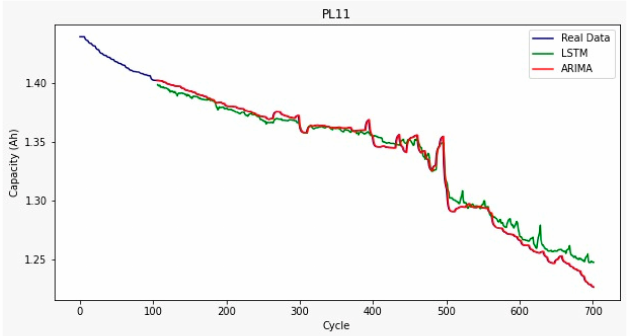
Figure 15. Train, test, and predicted data results from ARIMA and LSTM models for PL11.